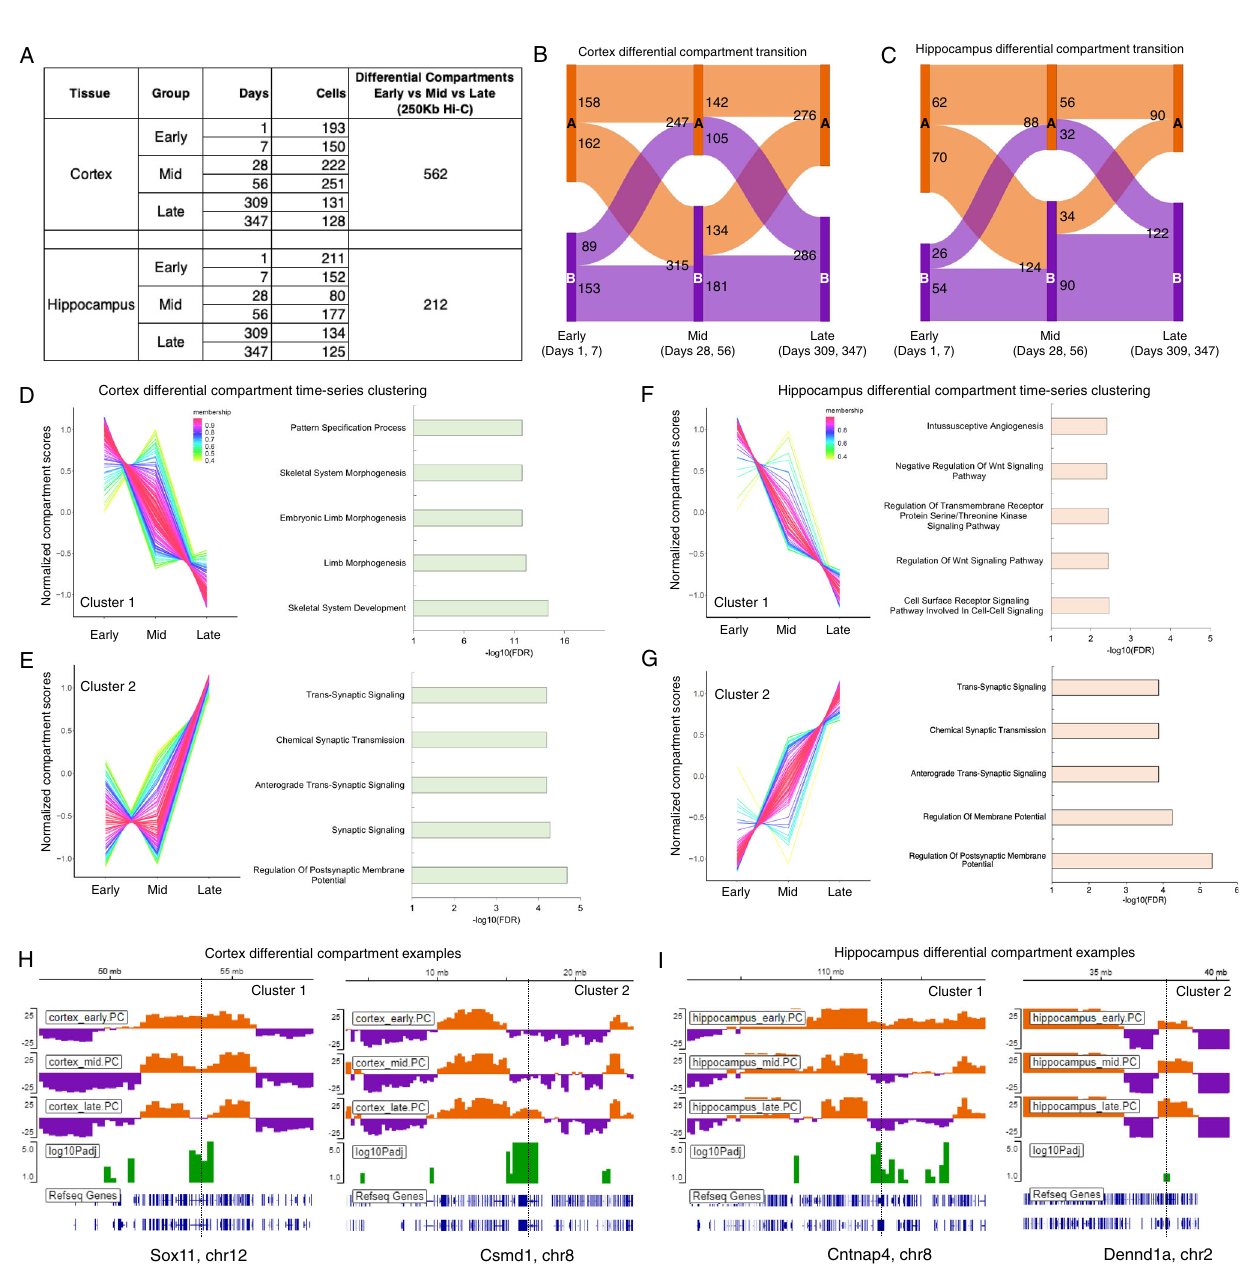
Fig. 8 | Differential compartment analysis of pseudo-bulk single-cell Hi-C data from post-natal mouse brain development. A Single-cell Hi-C summary and our categorization of 6 time points from each mouse brain region into three groups, namely – Early (includes Day 1, 7), Mid (Day 28, 56), and Late (Day 309, 347). B , C The transition of differential compartments in Early, Mid and Late groups within cortex and hippocampal region. D , E Time-series clustering of differential